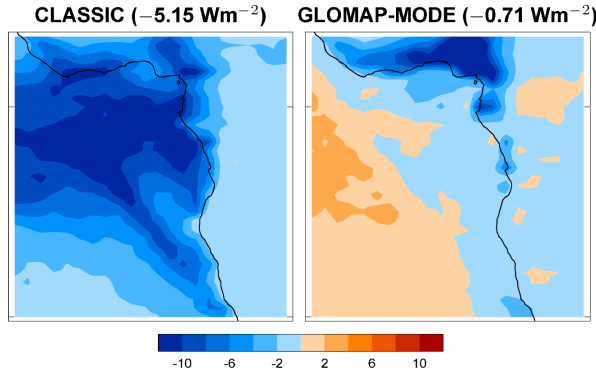
Figure 3. The annual mean aerosol indirect effect (cloud–aerosol interaction) and aerosol semi-direct effect diagnosed for two aerosol schemes (CLASSIC and GLOMAP-MODE) within the HadGEM2 climate model. Units are Wm − 2